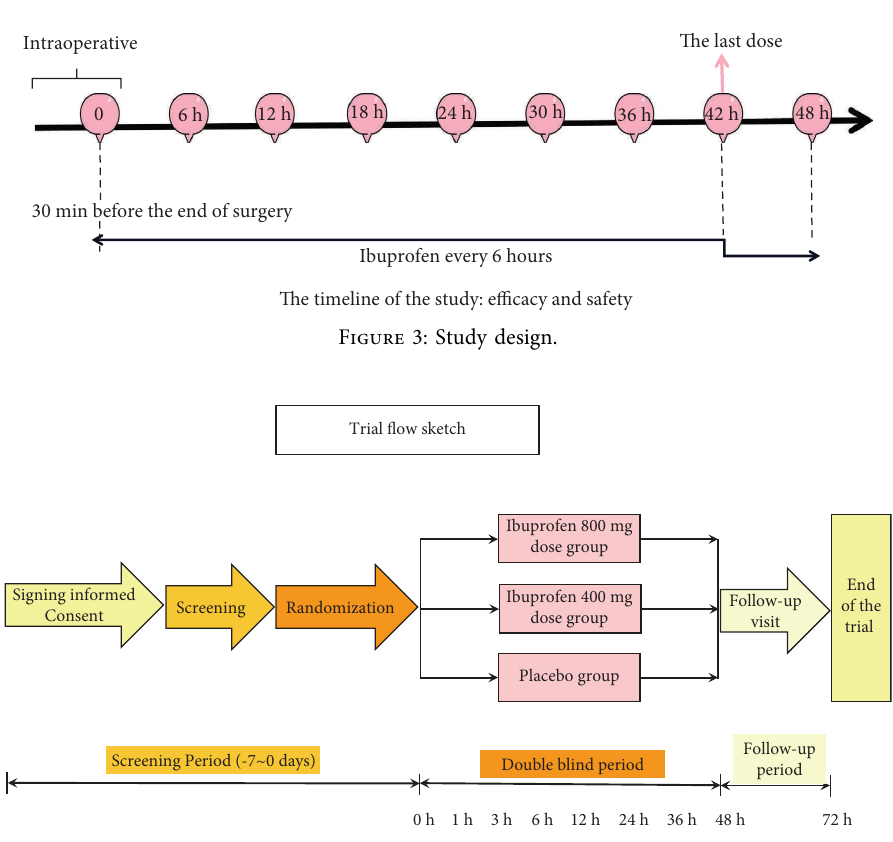
Figure 4: Te whole clinical trial